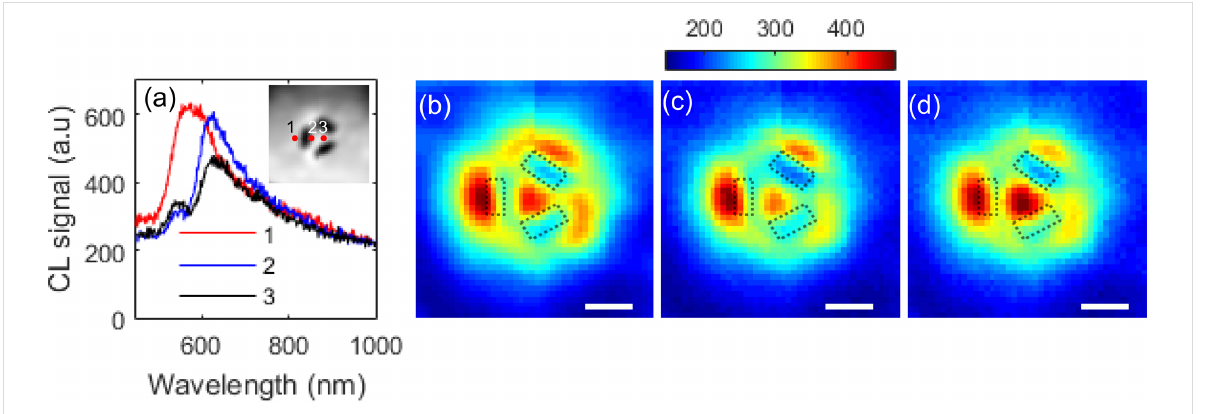
Figure 2: (a) CL spectra obtained from trimer slot structures with L = 95 nm, W = 40 nm and S = 60 nm obtained at different positions shown in the inset. The spatial dependence of CL emission in spectral bands (b) 550–560 nm, (c) 595–605 nm and (d) 610–620 nm are also shown. The scale bar in (b–d) is 100 nm.